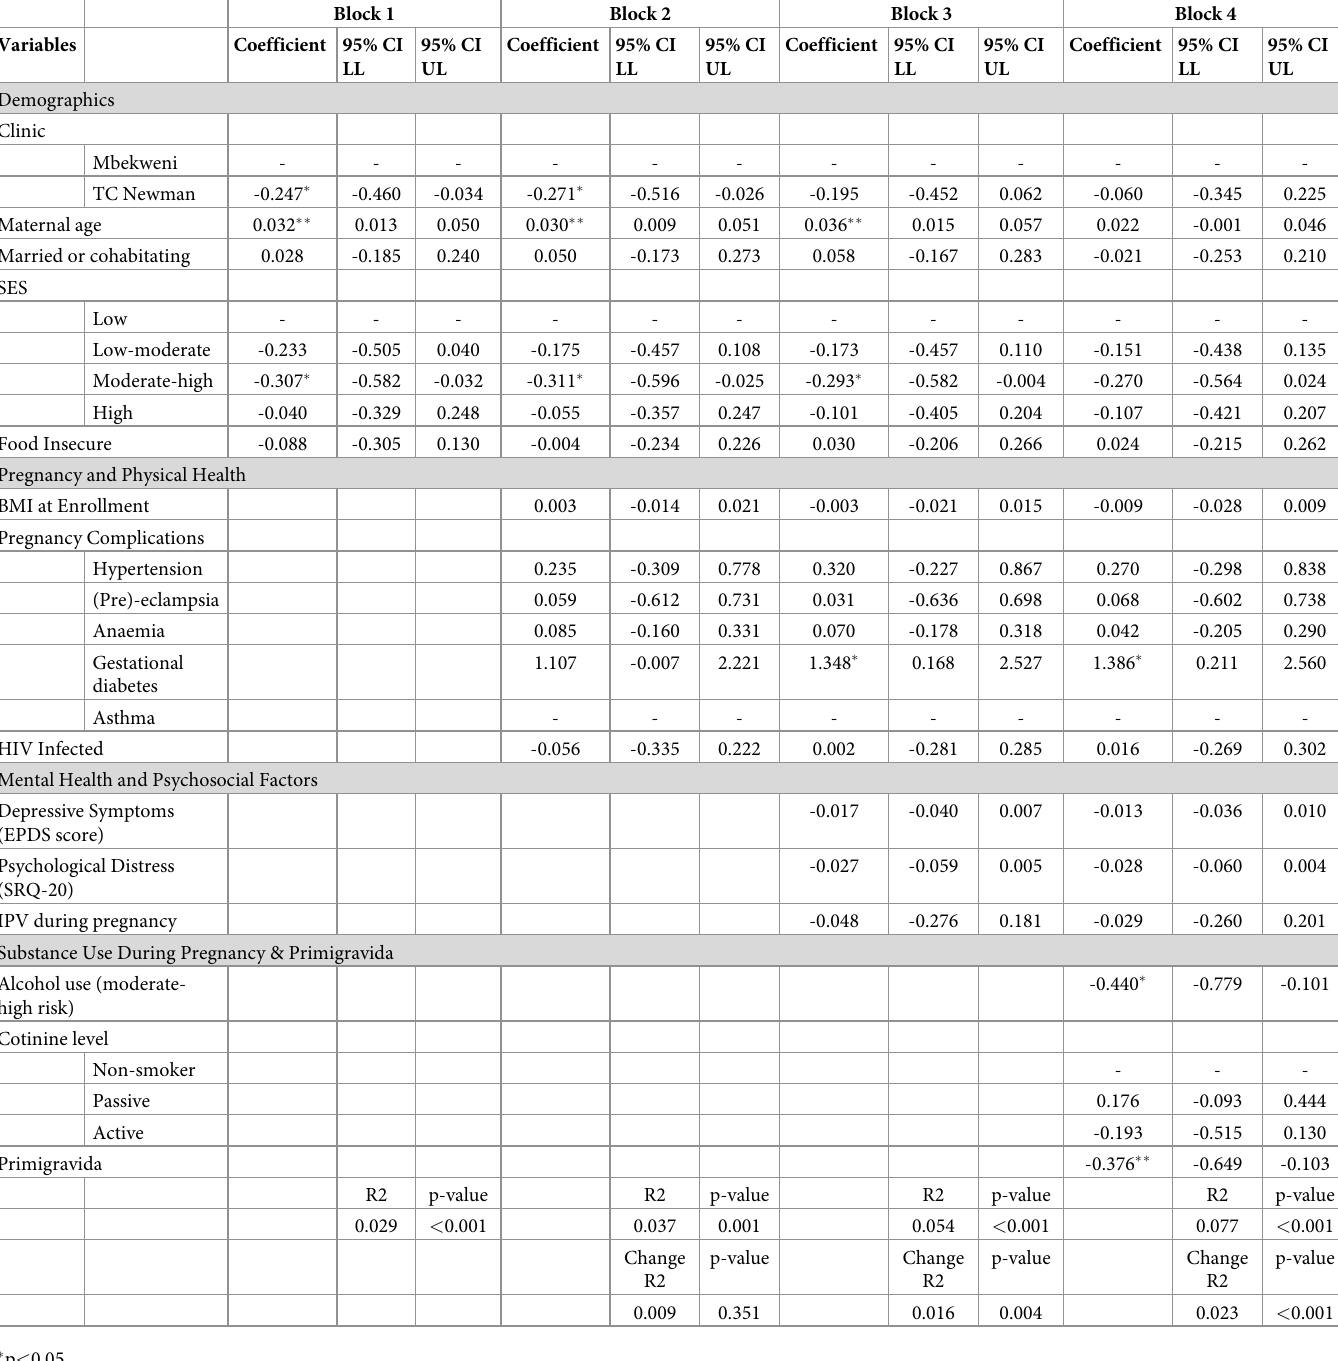
Table 5. Hierarchical regression predicting head circumference for gestational age (Z-score; N Final model =